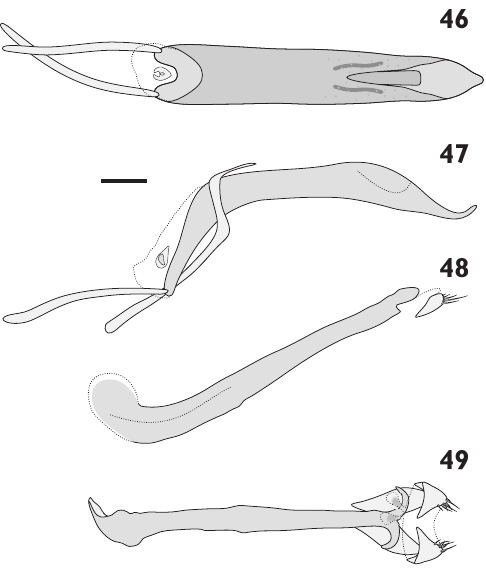
Figures 46–49. Genitalia of Austromonticola caelibatus . 46 penis, dorsal view 47 aedeagus, lateral view 48 male hemisternites 8 and spiculum gastrale, lateral view (membrane between hemisternites 8 and basal plate indicated) 49 male hemisternites 8 and spiculum gastrale with basal plate, ventral view. Scale bar = 0.5